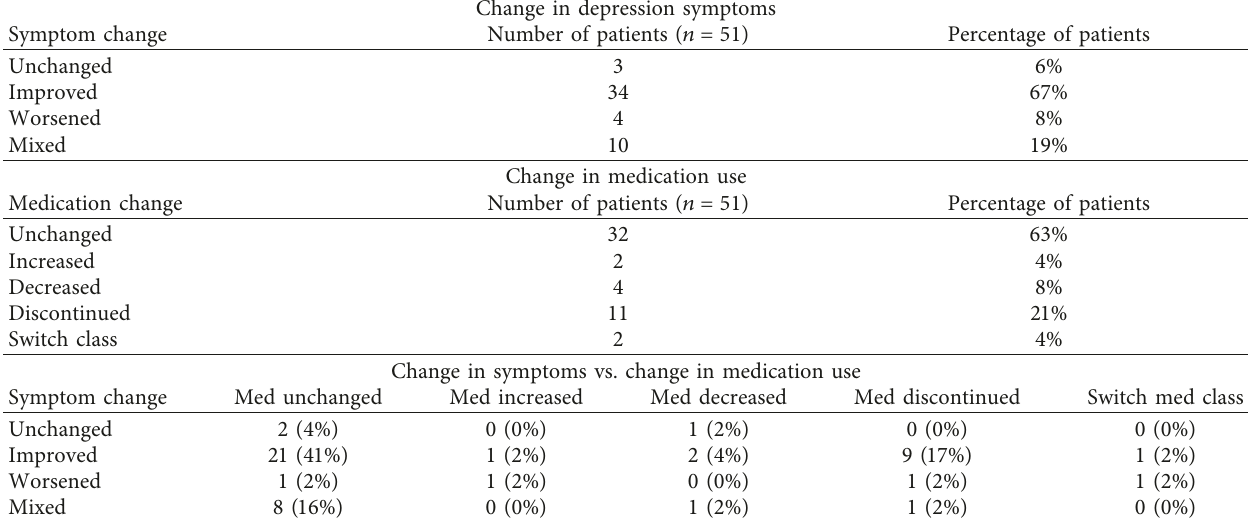
Table 2: Change in depression symptoms compared to change in medication use ( n �